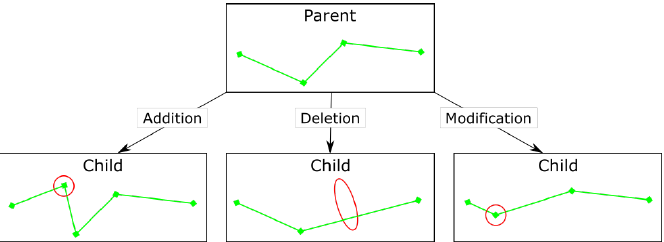
Figure 3. Possible functions of a Genetic Algorithm mutation operator in a 2D path optimisation example.